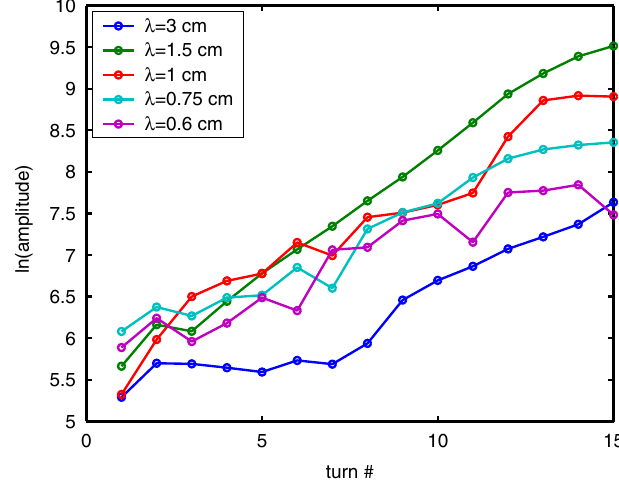
FIG. 7. (Color) Linear particle density profiles for turns 7, 11, and 15. The average level equal to 430 was subtracted. Only the central (cid:9) 15 cm part of a 40 cm long bunch is shown. The charge density is in arbitrary units.